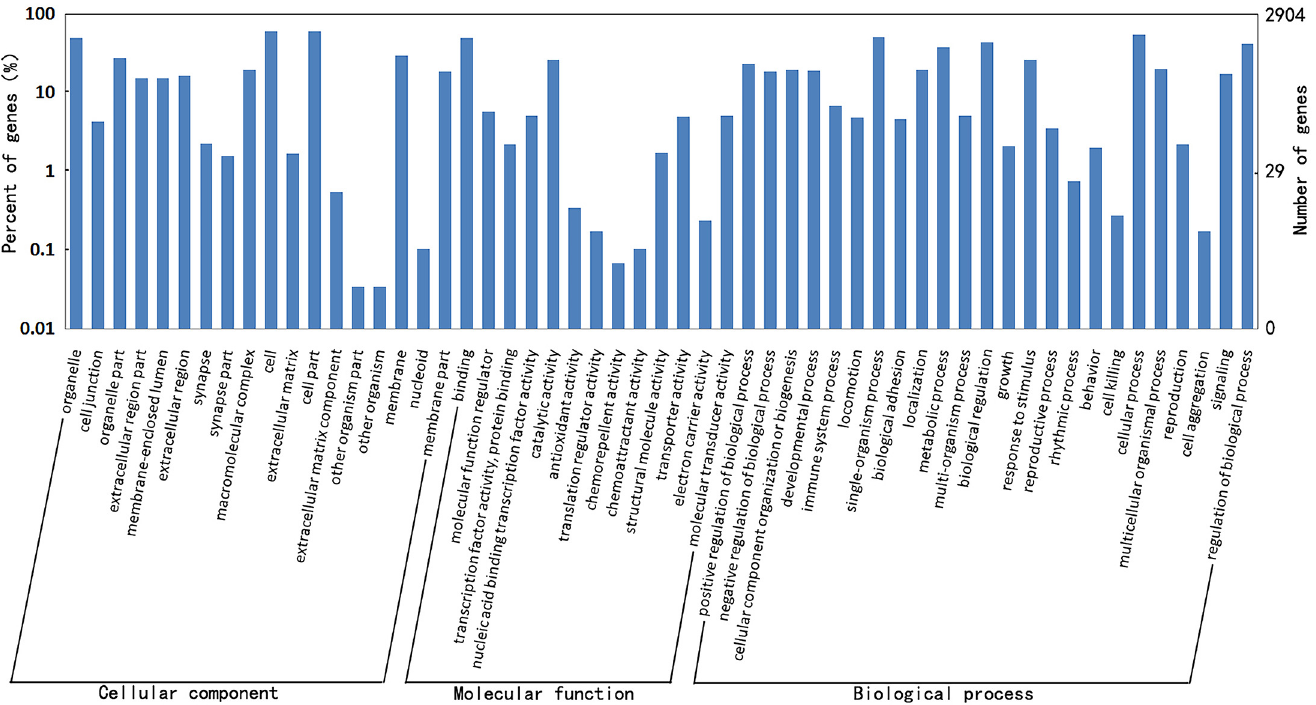
Fig 6. GO annotation on host targets of the viral miRNAs. The figure showed the GO annotation of these targets in biological processes, cellular components and molecular functions.